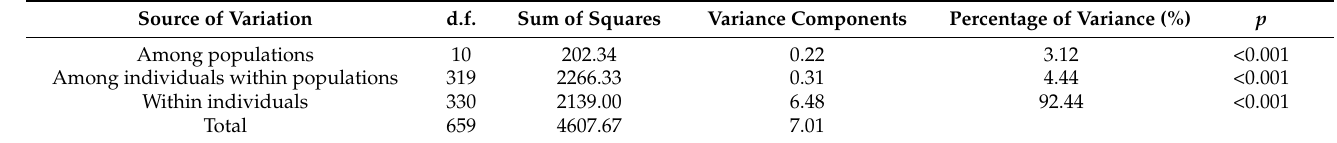
Table 5. AMOVA partitioning of molecular variance of Chinese fir in 11 sampling localities.